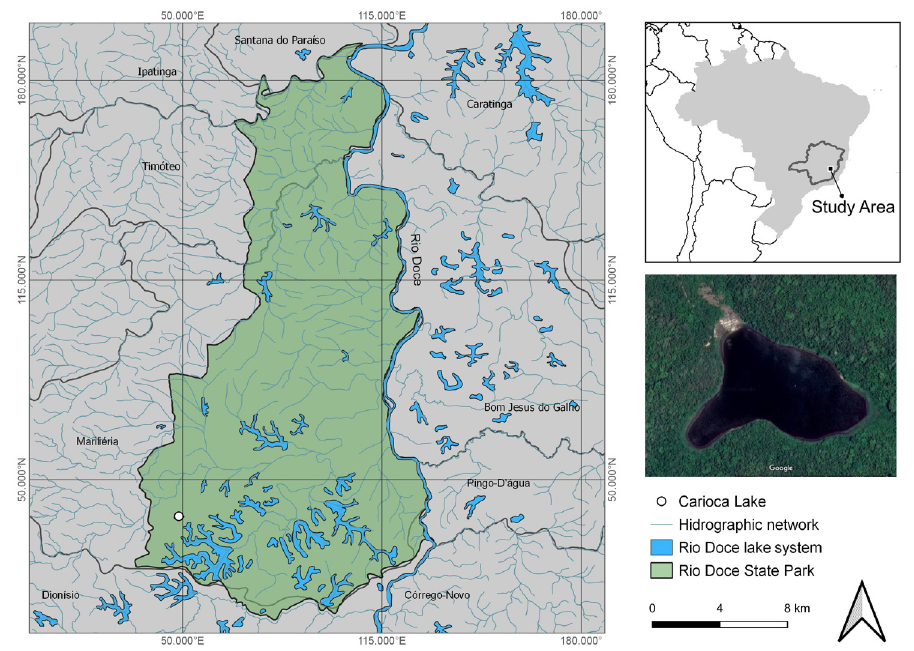
FIGURE 1 | The lacustrine system of the Middle Rio Doce basin, state of Minas Gerais, Brazil. The green polygon delimits the area of the Rio Doce State Park (PERD) and the white circle indicates the location of Carioca